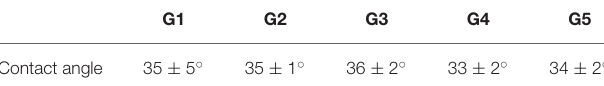
TABLE 3 | Water contact angle on graphite grades, measured